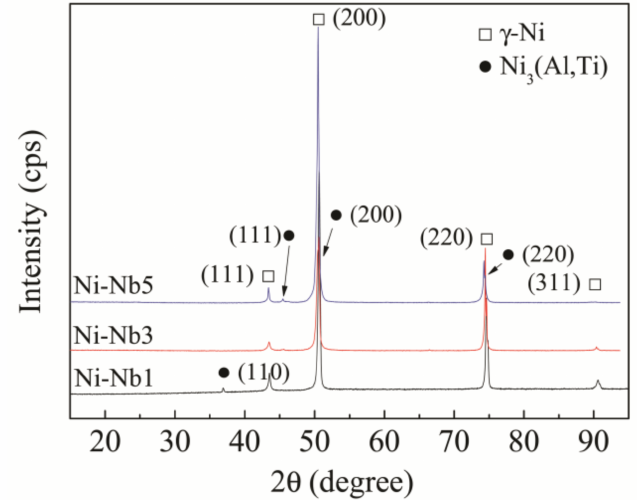
Figure 6. XRD maps of nickel-based alloys subjected to heat